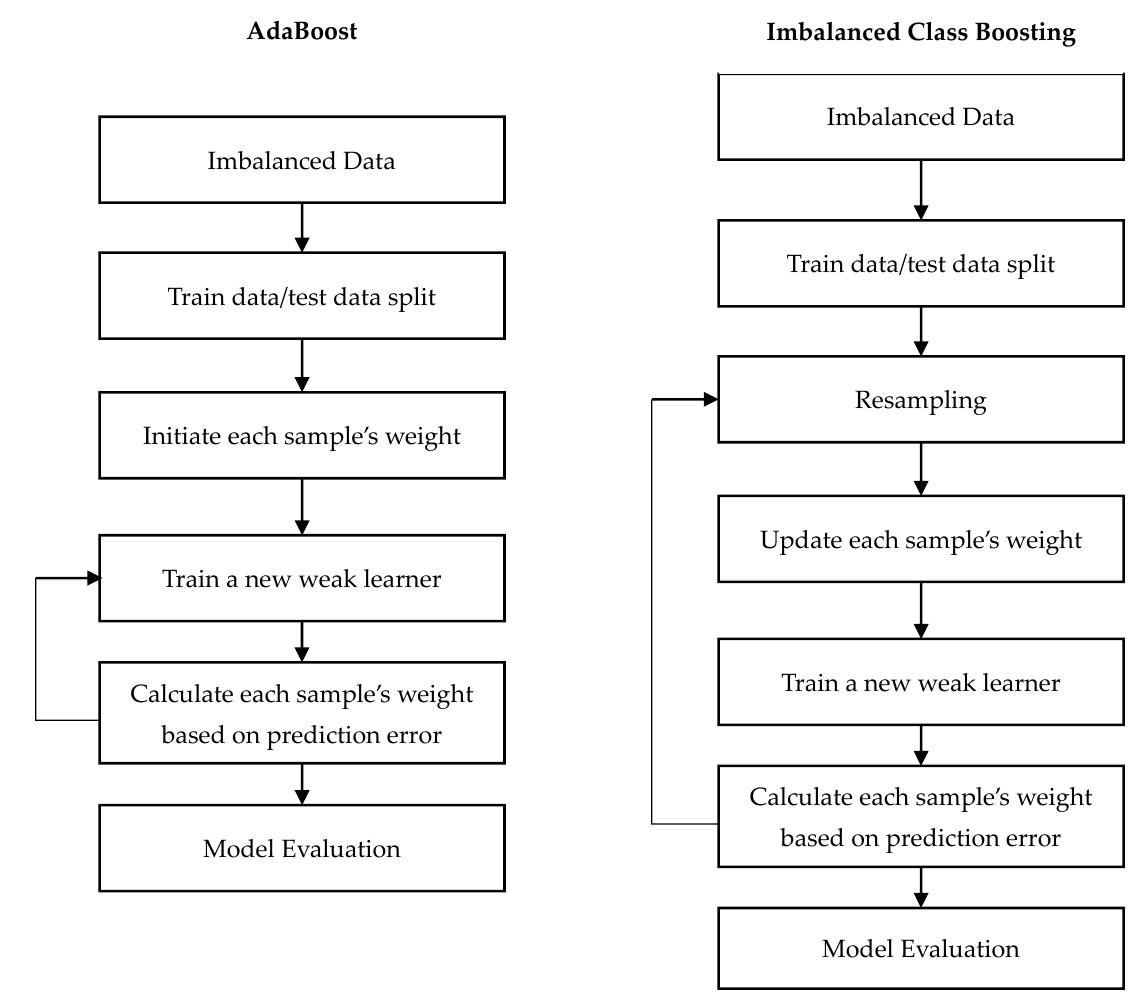
Figure 2. Difference in procedure between AdaBoost and imbalanced class boosting. Figure 2. Di ff erence in procedure between AdaBoost and imbalanced class